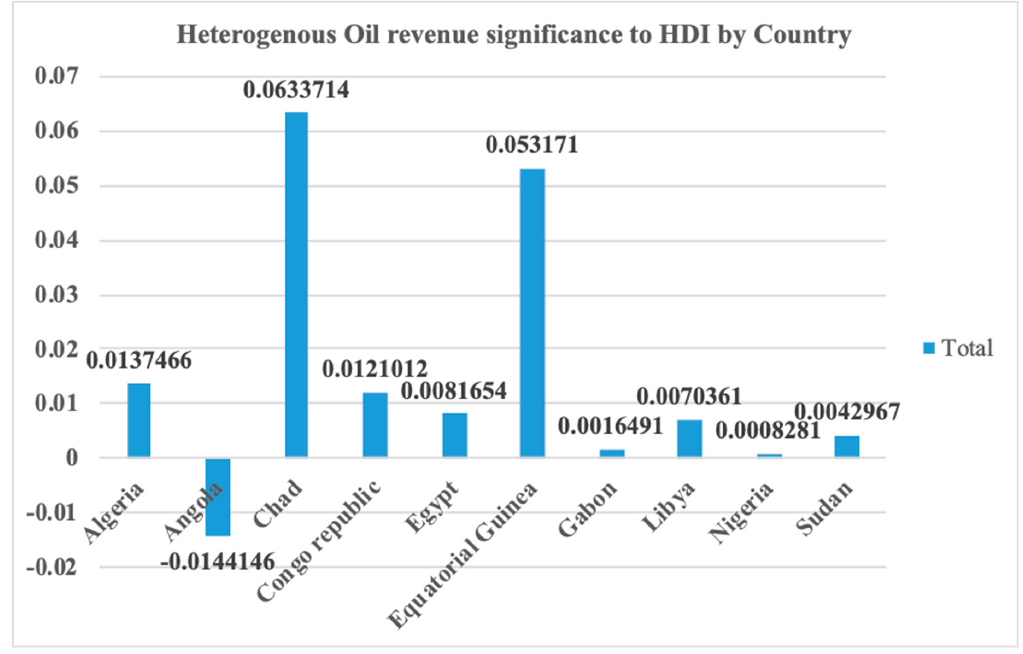
Figure 7. Oil revenue’s significance to sustainable development by country. Source: World Bank group data, (2019). Table 13. Panel ARDL oil revenue, short-run coefficients.